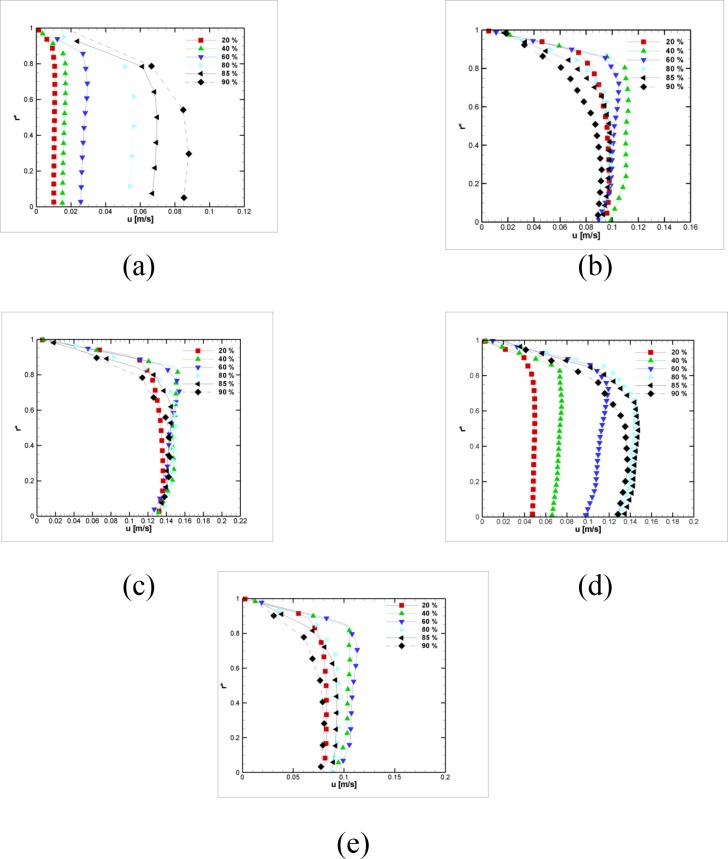
Velocity in the axial direction distribution for six different stenosis blockage percent peaks at z = 2 cm (a) t = 0 s (b) t = 0.25 s (c) t = 0.5 s (d) t = 0.75 (e) t = 1 s, Lvessel
= 6 cm, Rvessel
= 1 cm.